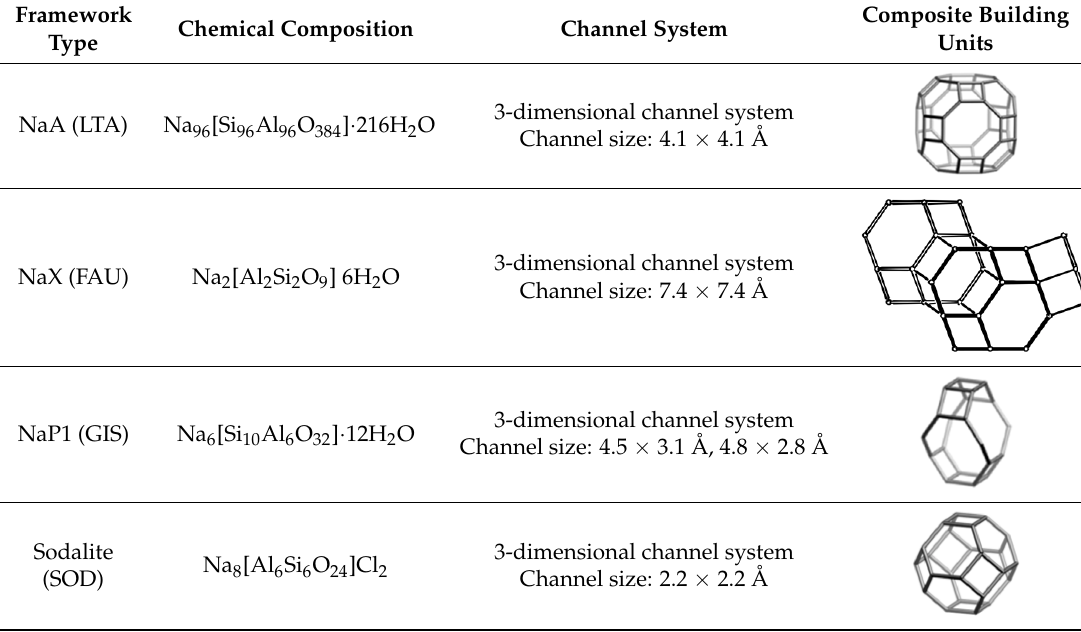
Table 1. Zeolite Framework Types appearing in the zeolite materials used in the research.